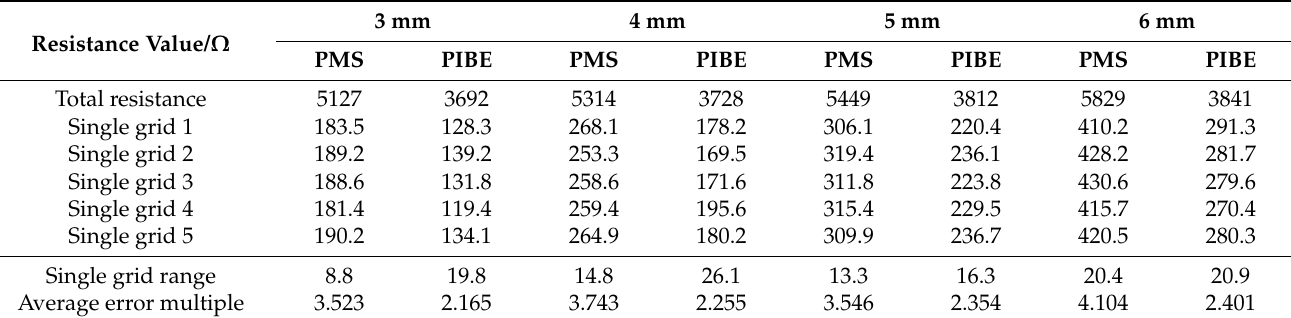
Table 1. Resistance of thin film with different grid lengths prepared by PMS and PIBE.